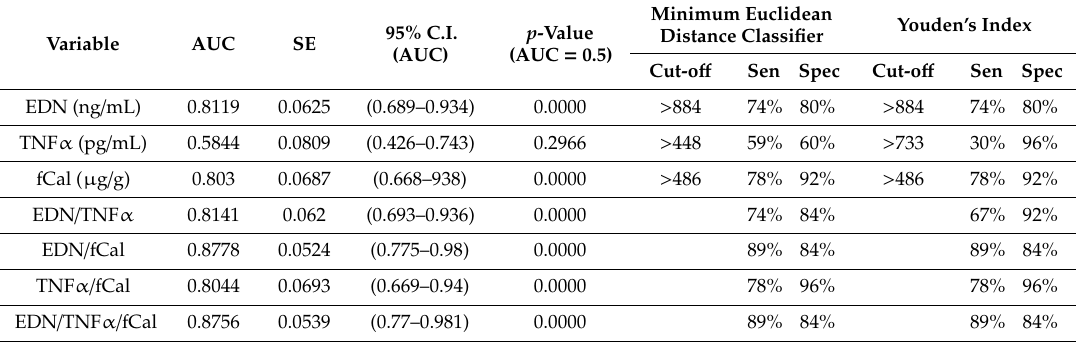
Table 2. Area under the curve (AUC), standard error (SE), confidence interval, sensitivity (sen), specificity (spec) of eosinophil derived neurotoxin (EDN), tumor necrosis factor α (TNF α ), and fecal calprotectin (fCal) among study